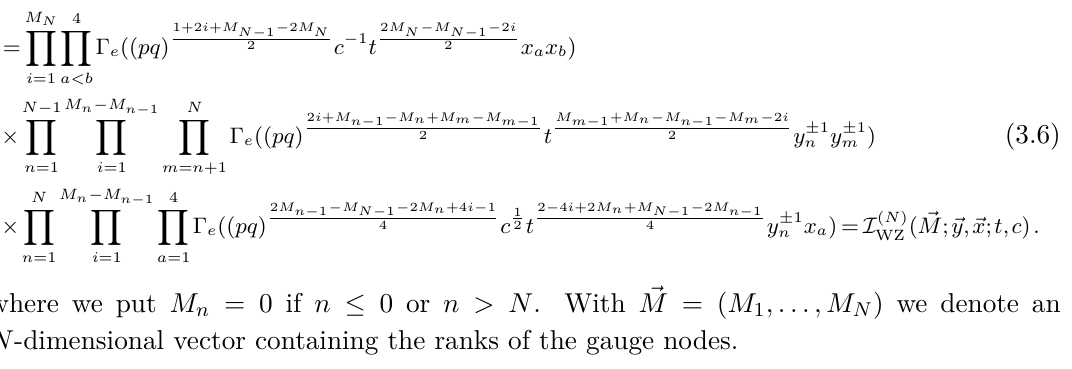
Figure 8 . The quiver diagram summarizing the field content of the USp(2 M ) × USp(2 N ) gauge theory. Later we will also refer to it as Theory